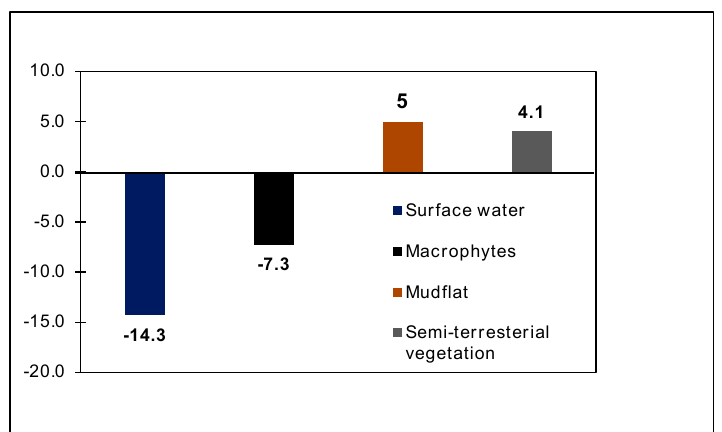
Figure 7. Overall change in area distribution of four major target classes between 1986 and 2016 in and around Lake Ziway based on NDAVI and Modified Normalized Difference Water Index (MNDWI) classification.